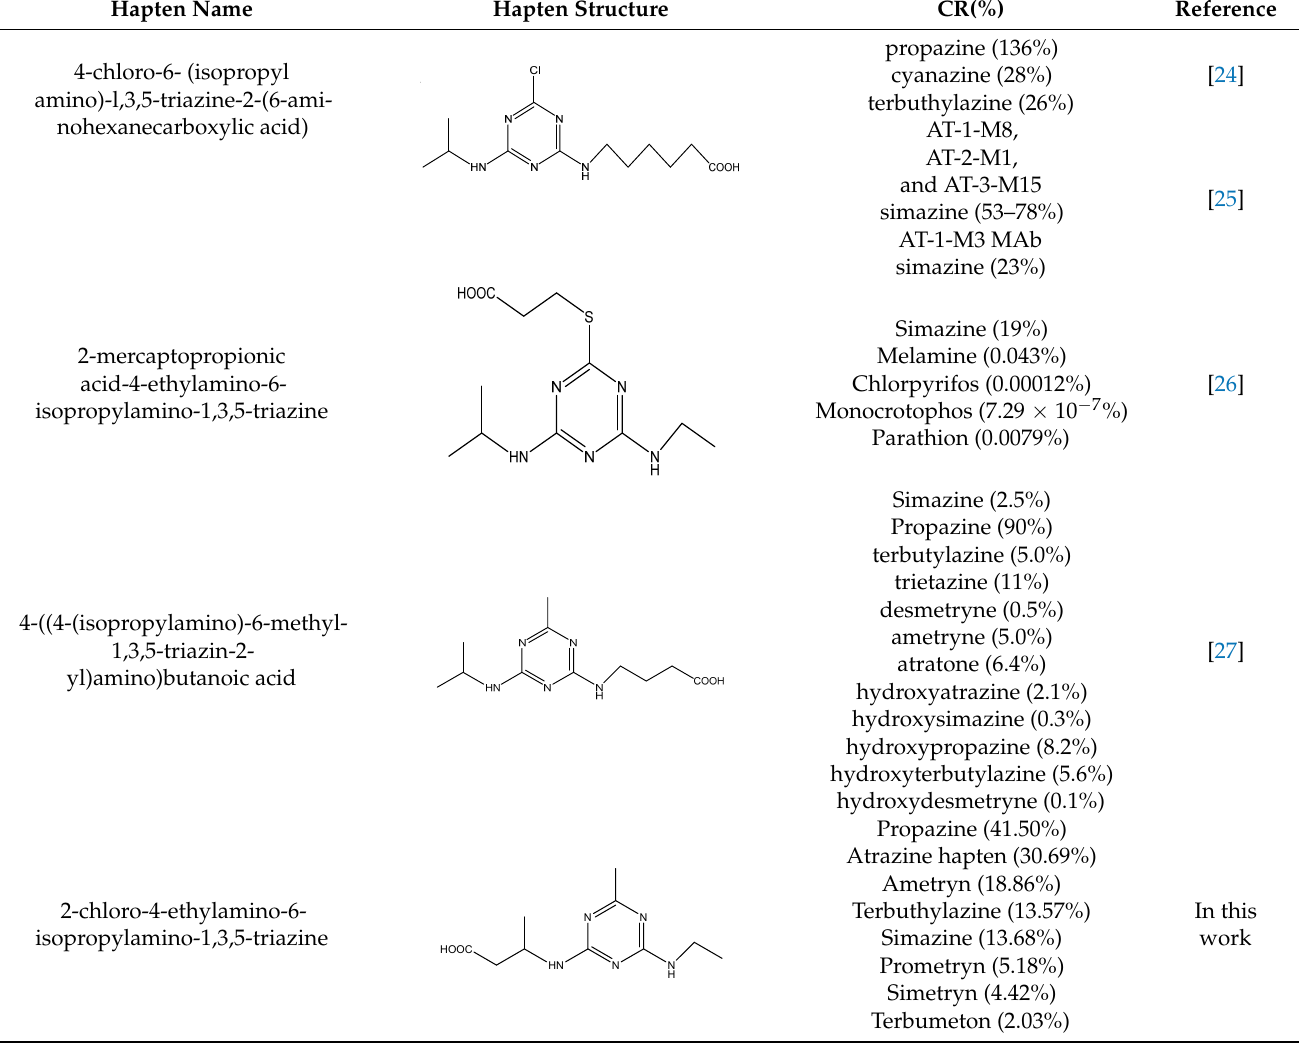
Table 7. Comparison with previously reported atrazine hapten structures and cross-reaction rates.